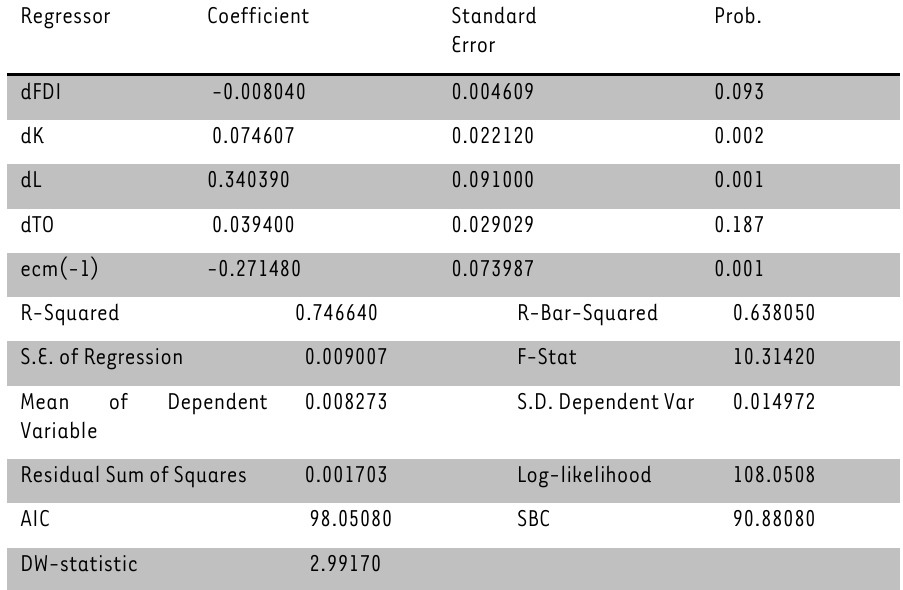
TABLE A2: Error Correction Representation for the Selected ARDL Model Dependent variable is